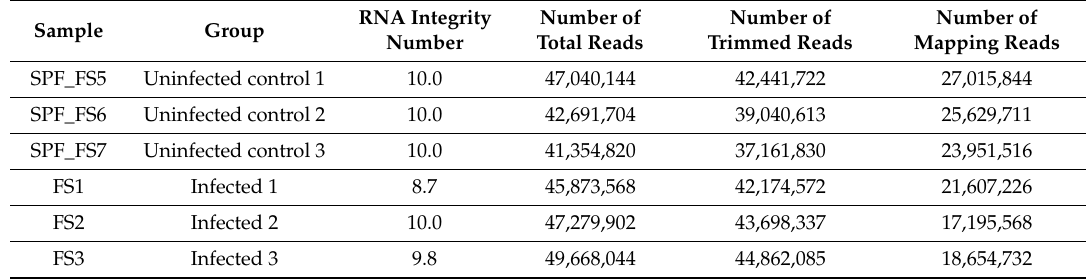
Table 1. Sample description and numbers of RNA-seq reads. RNA-seq analysis of F. sultana zooids was performed using CLC Genomics Workbench 12